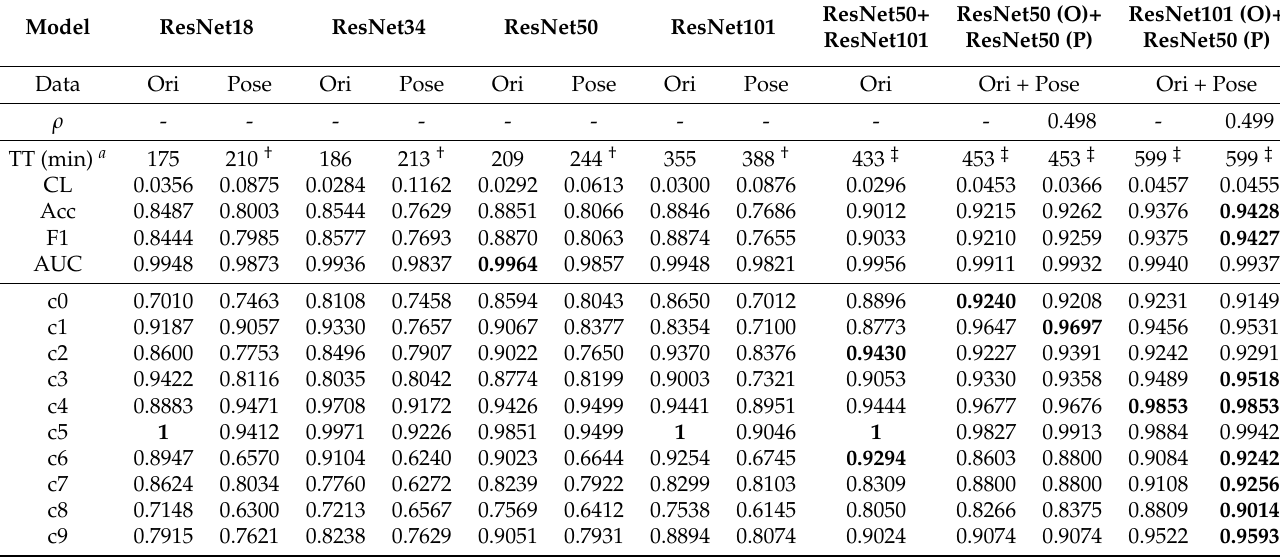
Table 3. The training time (TT), validation cross-entropy loss (CL), accuracy (Acc), F1 Score (F1) and individual F1 Score for each class on AUC-DDD v2 dataset for different configuration of ResNet. Please note that all models are trained with “one-cycle” learning rate, with batch size of 32 and image size of 360 2 . Best results are in bold.